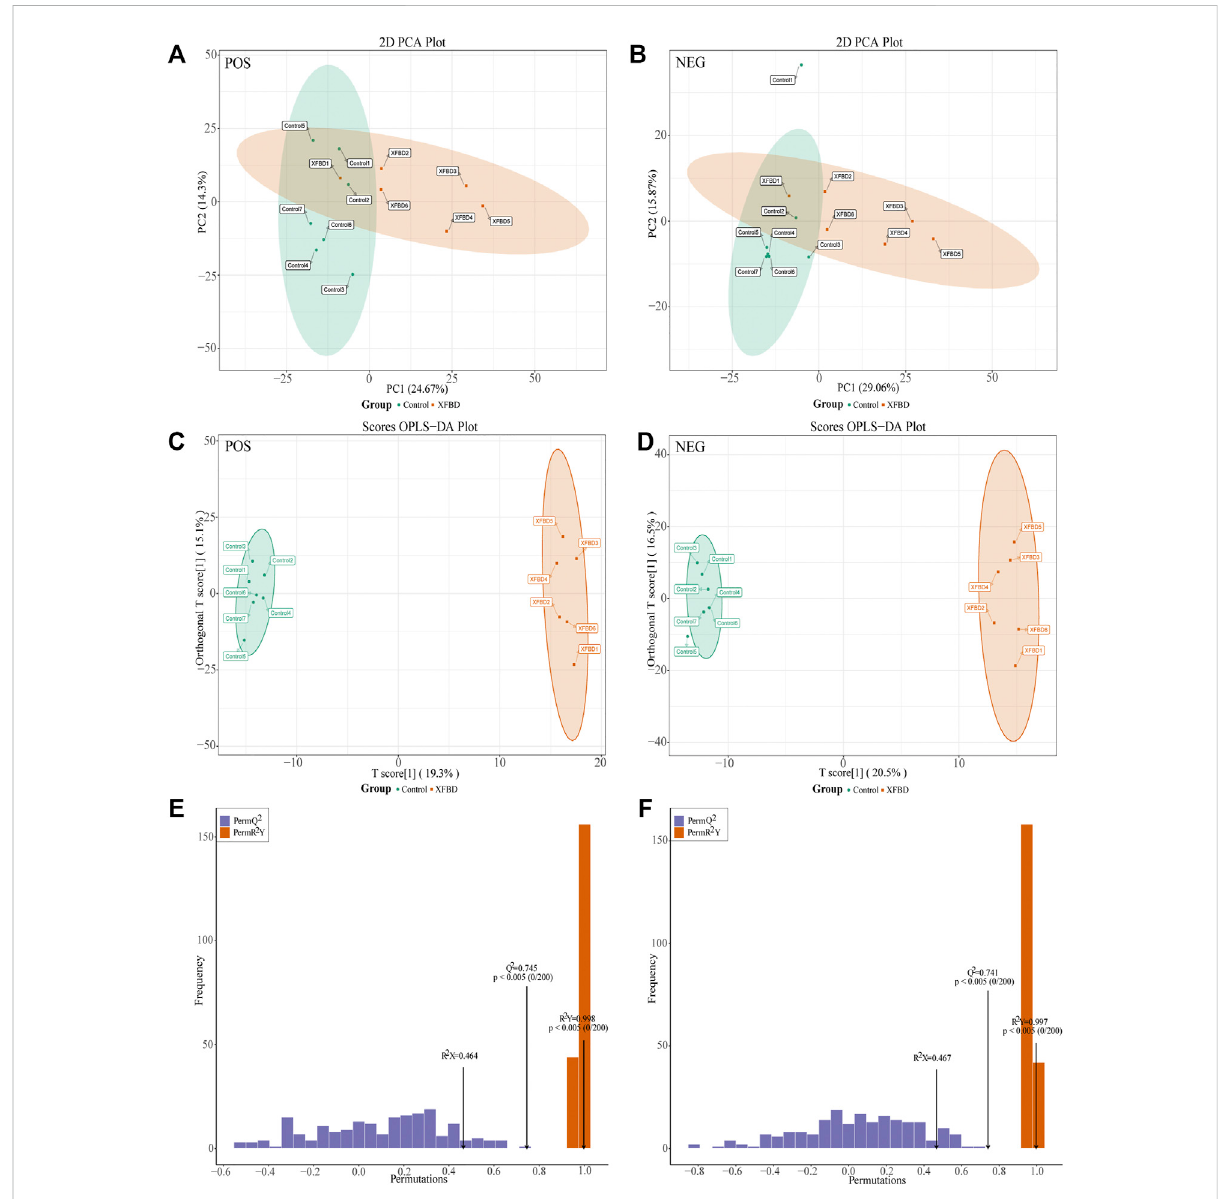
FIGURE 2 Metabolic pro fi lingbetweencontrol and XFBD group. (A) Score plotofPCA model inpositive ion mode. (B) Score plotof PCAmodel innegative ionmode. (C) ScoresplotoftheOPLS-DAmodelinpositiveionmode. (D) ScoresplotoftheOPLS-DAmodelinnegativeionmode. (E)